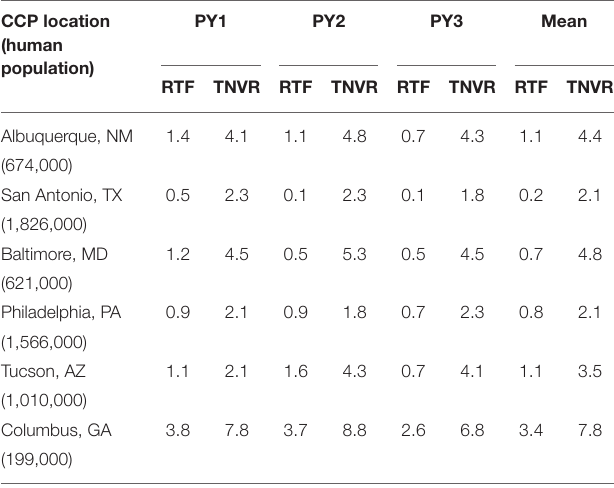
TABLE 3 | Number of RTF and TNVR surgeries performed annually per 1,000 human residents in each of six 3-year CCPs. CCP location